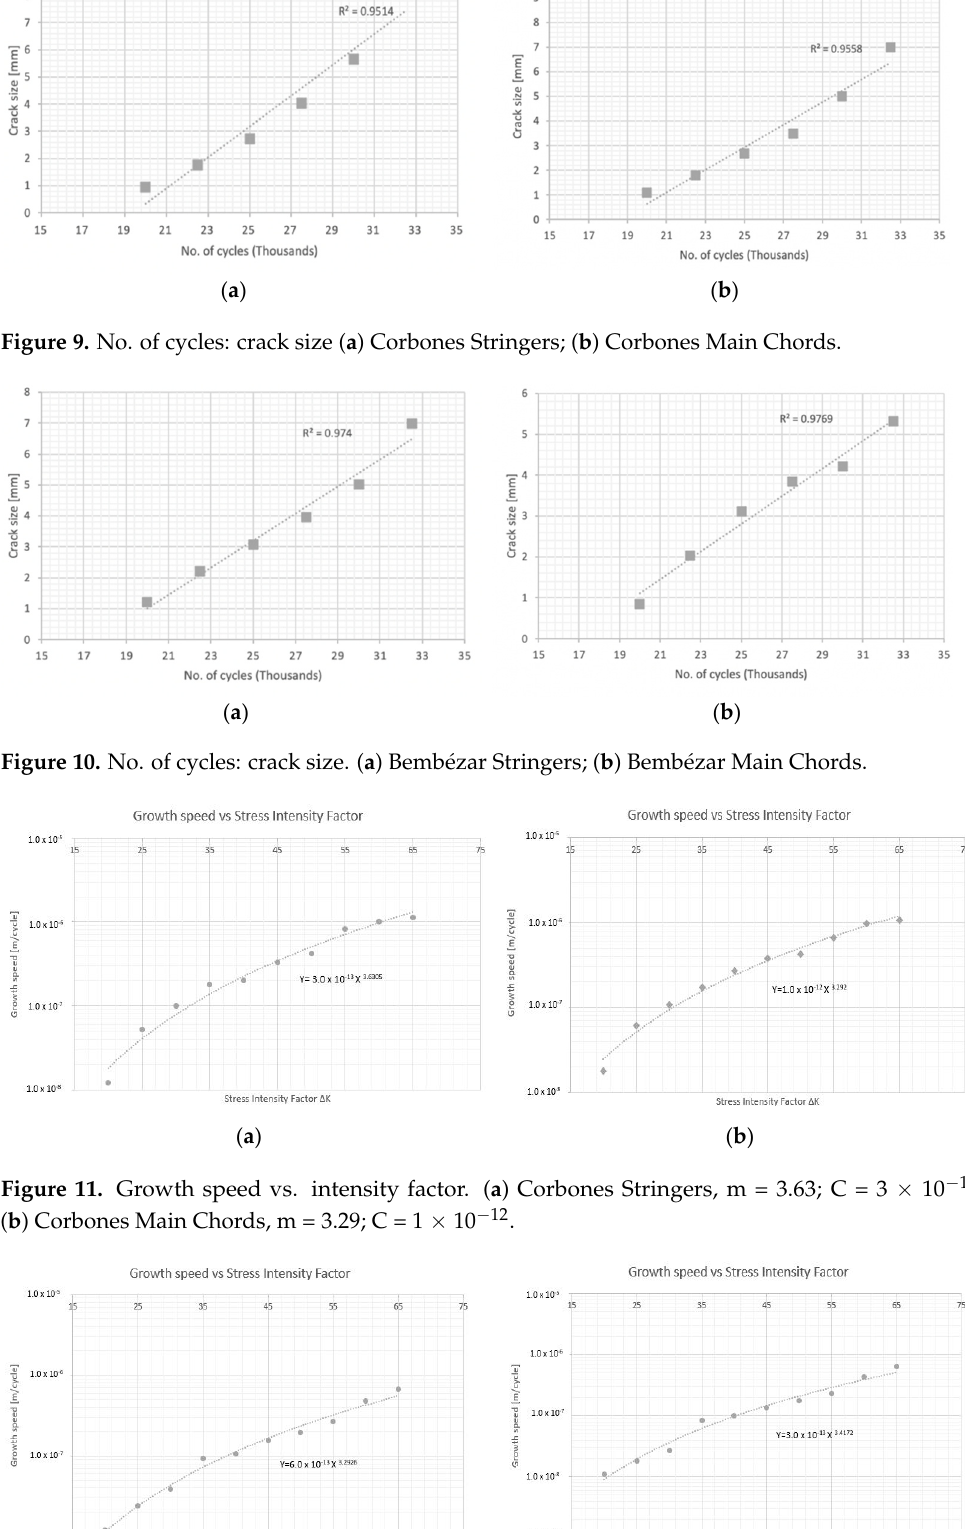
( a ) ( b ) Figure 13. Crack growth sequence example ( a ) Bembézar Stringers; ( b ) Bembézar Main Chords. The width of each image corresponds to 5 mm. For phase three, fatigue tests equivalent to 100 and 200 MPa were carried out using a flat-sheet fatigue specimen with a rectangular cross-section. In all cases, for the loads used, no crack was generated after 10 7 cycles, so it was estimated to be below the natural endurance limit of the material. Therefore, it was insensitive to fatigue failure unless it has some initial imperfection that triggered the appearance of the crack, after which the crack spreads. The studies continued with the fourth phase by incorporating a double notch in the specimens. Doing so, the section continued to be symmetrical, and no bending appeared that could make the interpretation of results more complex but, at the same time, the notch triggered the appearance of a growing crack. On the following tables and figures (Tables 4–7 and Figures 14 and 15) the results for fatigue tests on double-notched samples are shown along with fractographic images after the break. This test was performed on samples from the seven bridges. The results for the “Bembézar” and “Corbones” bridges are presented explicitly. The other results are summarized in Table 8.